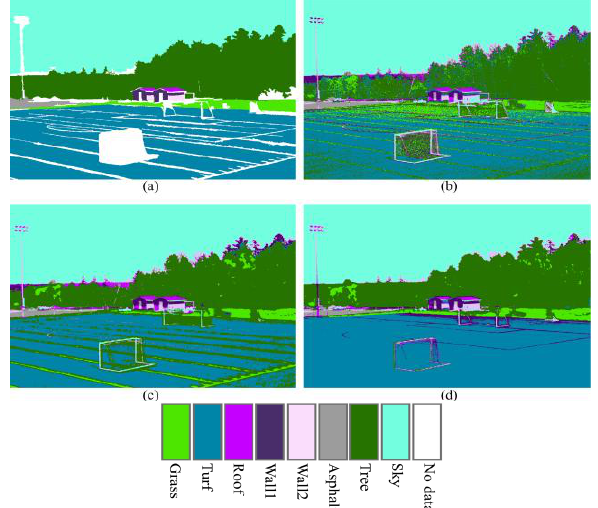
Figure 7: Classification results of Scene 2 images including (a) ground truth data generated manually and the classification results of (b) HRC image, (c) Vpan-RGB fused image, and (d) Pan-NRGB fused